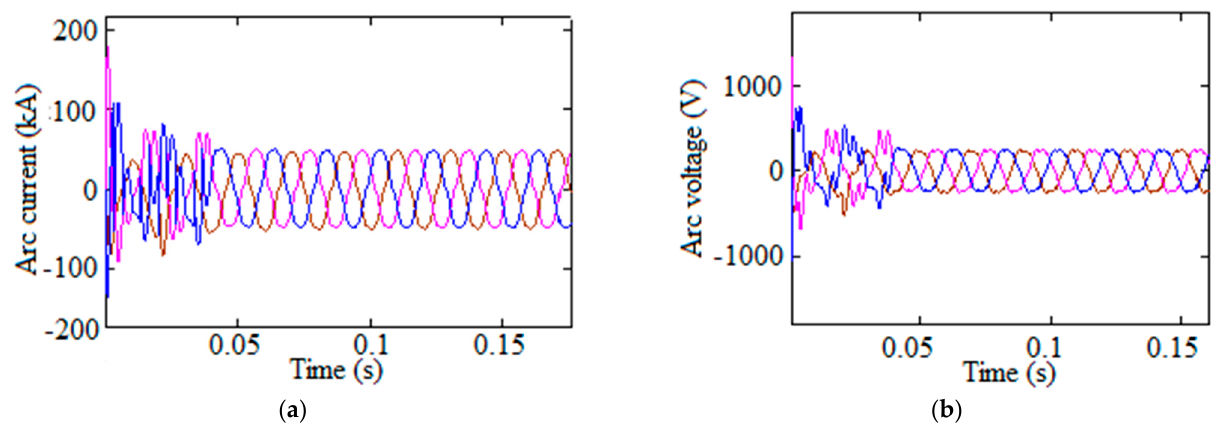
Figure 14. Flicker analysis ( a ) Current ( b ) Voltage.